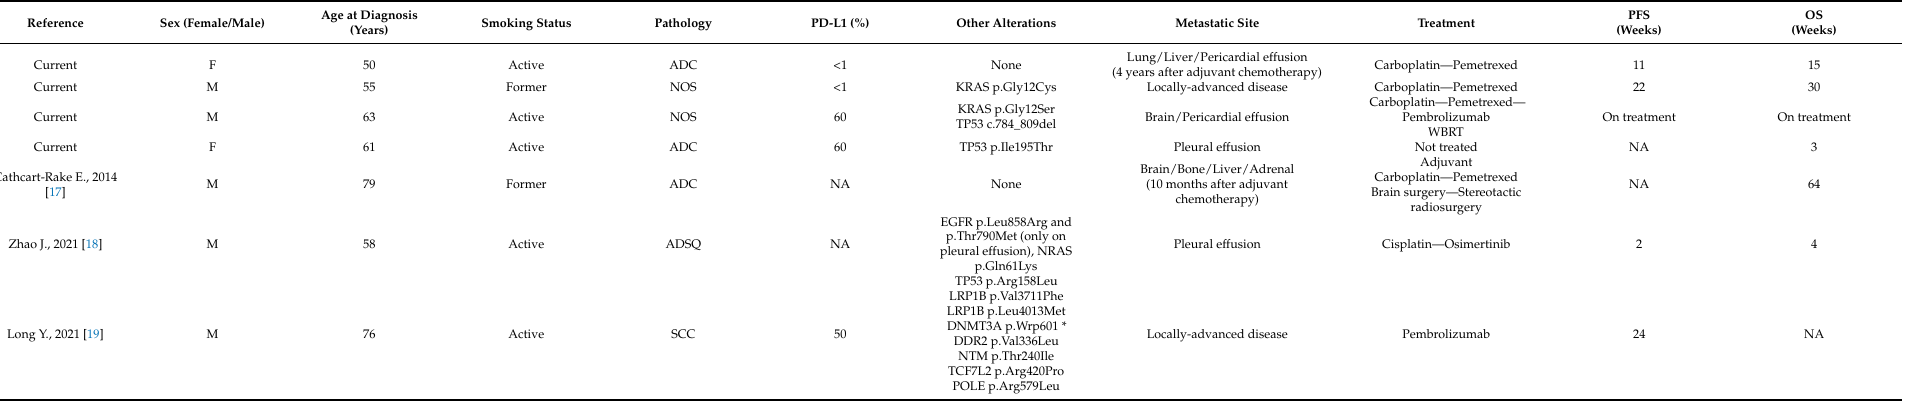
Table 2. Clinico-pathologic features of non-small cell lung cancer patients with HRAS p.Gln61Leu mutation reported in literature. ADC: adenocarcinoma; SCC: squamous cell carcinoma; ADSQ: adenosquamous; NOS: not otherwise specified; WBRT: whole brain radiotherapy; PFS: Progression-Free-Survival; OS: Overall Survival; NA: Not